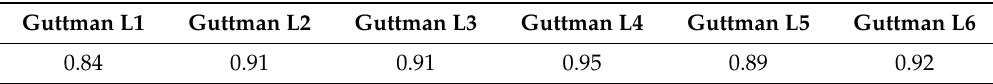
Table 3. Guttman’s reliability statistics.